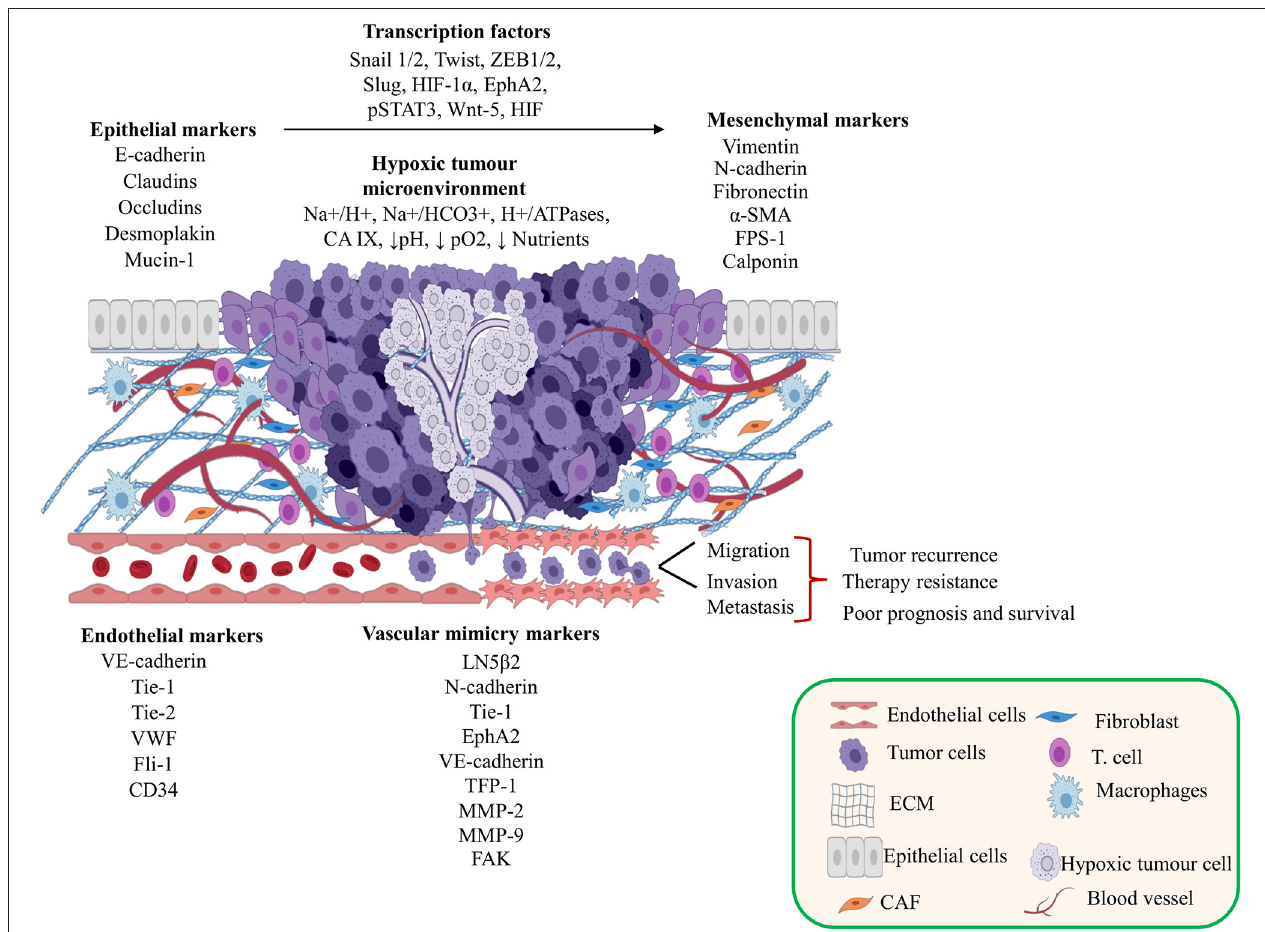
FIGURE 1 | Contribution of the tumor microenvironment and epithelial-mesenchymal transition (EMT) in vasculogenic mimicry (VM) formation. This figure shows the tumor microenvironment effects and the relationships between transcriptional factors, EMT, and endothelial cell markers during the development of VM. Created with